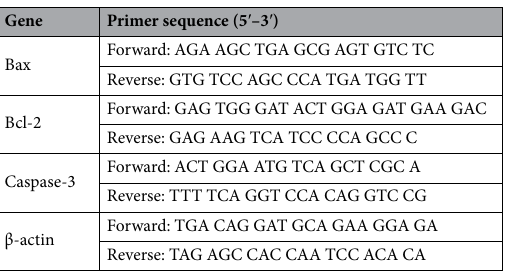
Table 1. Primer sequences.